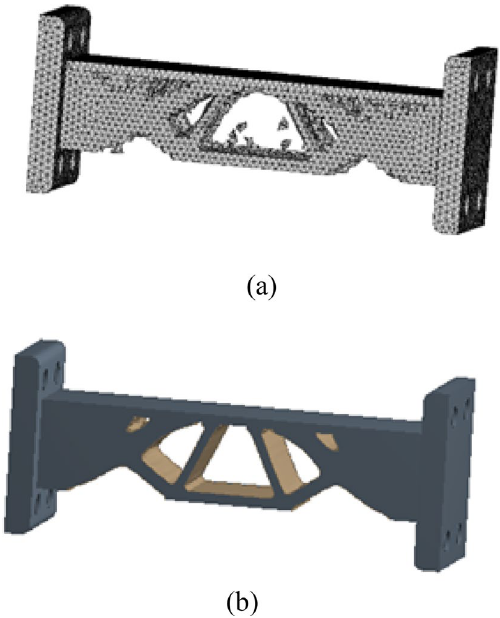
Figure 23. Comparison of optimization results with different optimization algorithms. ( a ) HCAM optimization result ( b ) FEM optimization result.